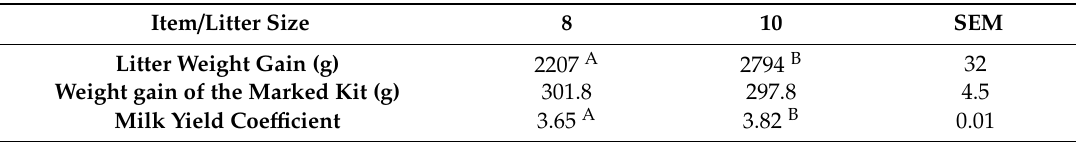
Table 4. The e ff ect of the litter size on litter weight gain (days 2–21), weight gain of the marked kit (days 2–21), and milk yield coe ffi